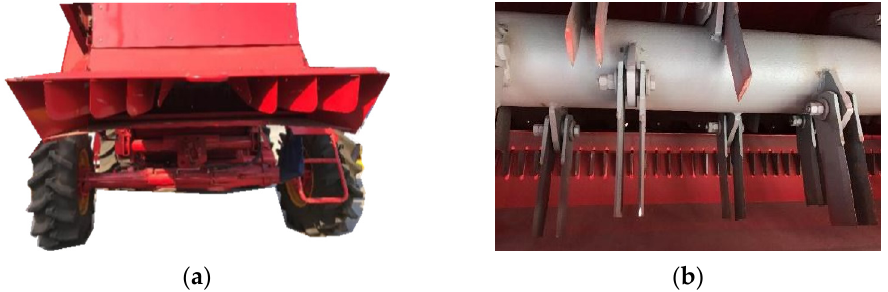
Figure 15. Lovol ASHNA harvester. ( a ) Straw deflector; ( b ) flail knife.